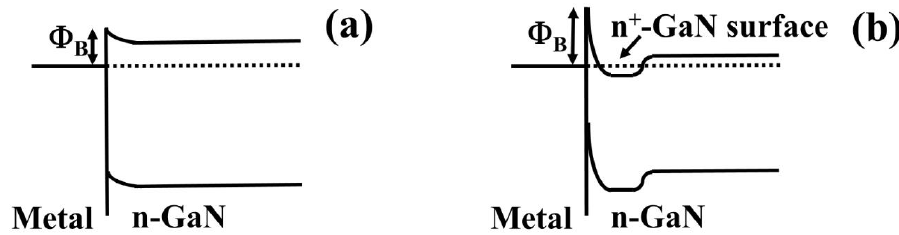
Figure 4. Energy band diagram of metal/(Al)GaN by reducing the barrier height( Φ B ) ( a ) and increas- ing the possibility of tunneling by forming n + -(Al)GaN surface ( b ).